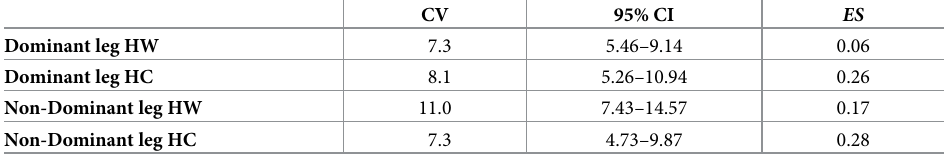
Table 1. Coefficient of variation (CV), confidence interval (CI) and effect sizes (ES) for day 1 vs day 2 in D and ND legs for 90:20 HW and HC positions.